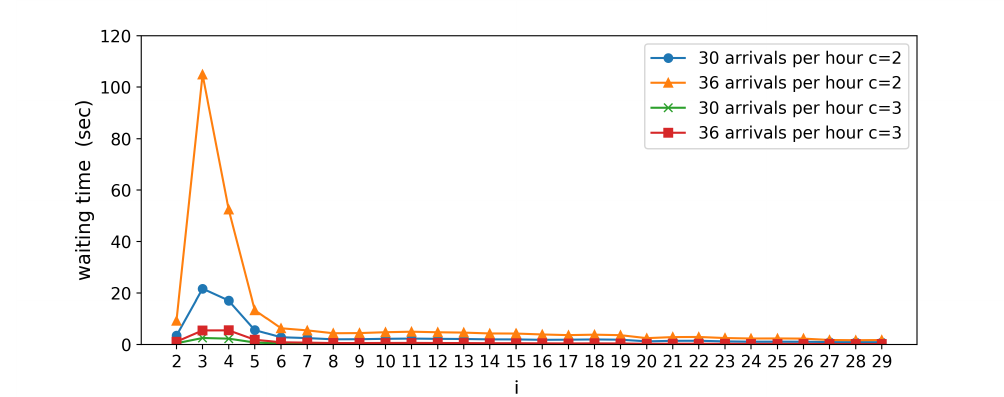
Figure 14. Comparison of the expected arrival delays for airspace capacities c = 2 and c = 3.